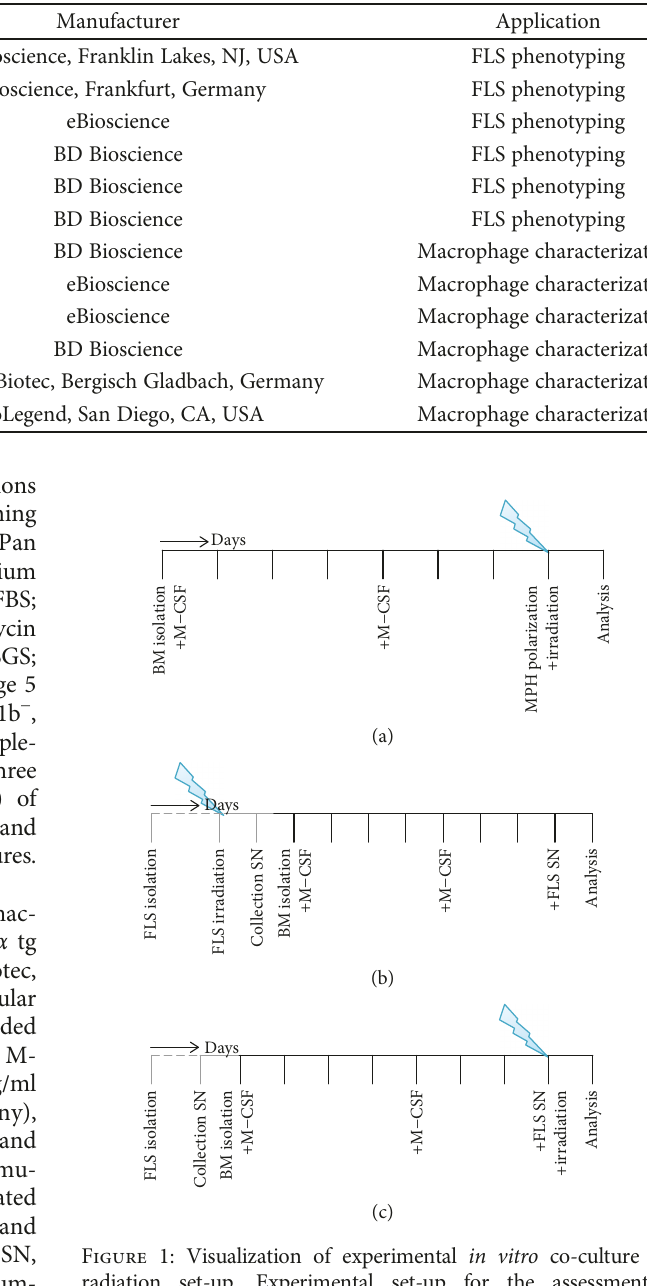
Table 1: Antibodies used for fl ow cytometry-based FLS and macrophage phenotyping.